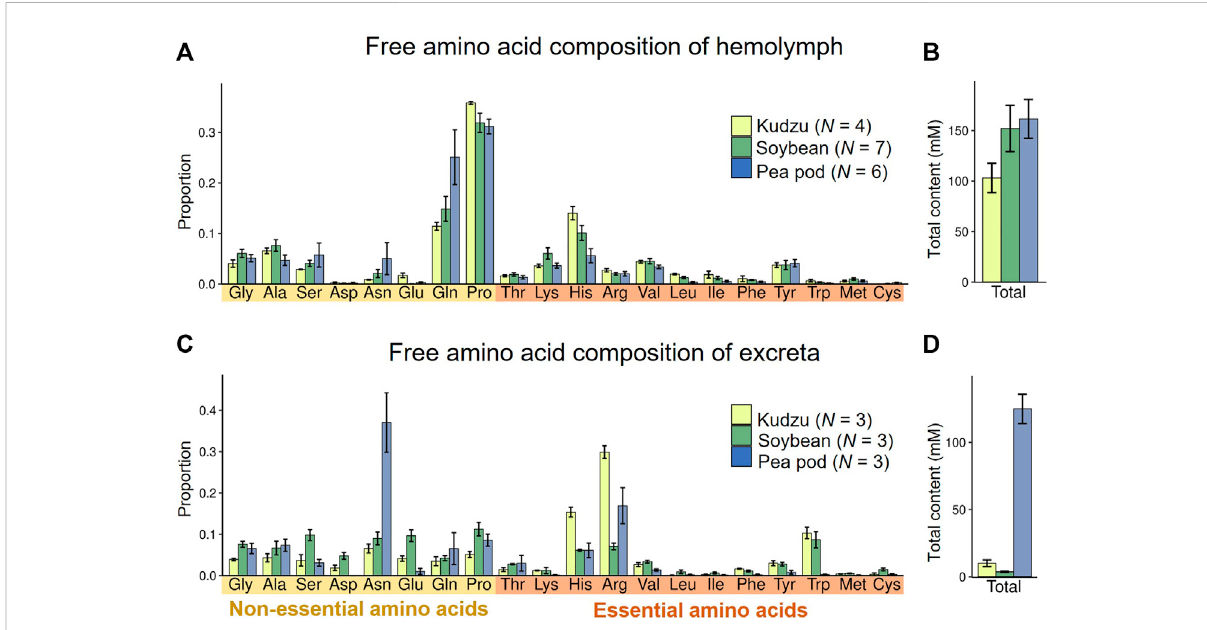
FIGURE 3 Amino acid compositions in hemolymph and excreta of M. punctatissima adults feeding on different diets, kudzu plant, soybean seedling, and peapod. (A,B) Relativeproportion ofeachaminoacid (A) andtotalamountofaminoacids (B) inthehemolymph.Means±s.e.mareshown( N =4-7). (C,D) Relative proportion of each amino acid (C) and total amount of amino acids (D) in excreta. Means ± s.e.m are shown ( N =